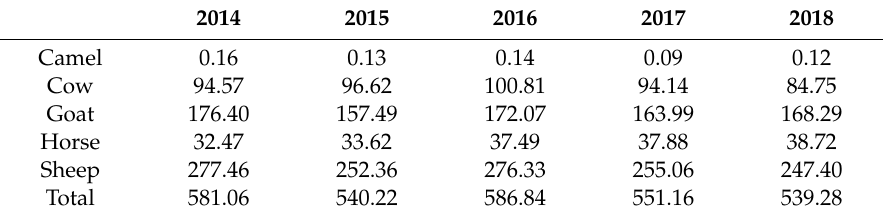
Table 1. Composition of livestock in the KRB (in heads of the respective animal types)